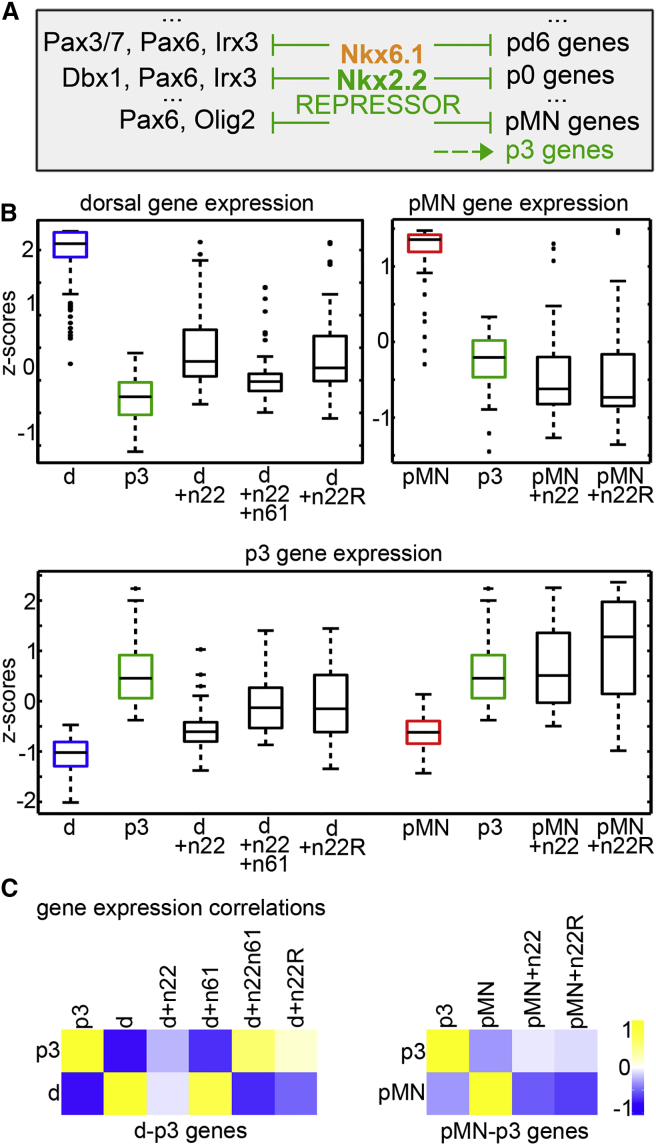
Regulation of Gene Expression Programs by NP-TFs Is Mediated by Repression(A–C) Nkx2.2 represses dorsal and pMN genes to induce p3. (A) Experimental rationale: to test whether repression of dorsal and pMN genes by Nkx2.2 is sufficient to allow the de-repression of p3-specific genes, a dominant inhibitory version of Nkx2.2 (n22R) was induced in iNPC-D or iNPC-pMN cells and the resulting transcriptome changes analyzed. (B) Nkx2.2HD-EnR is sufficient to repress a large fraction of dorsal and pMN genes and to induce p3 identity. Three groups of genes defined in Figure 1D were analyzed: “dorsal” genes (blue) that were expressed higher in iNPC-D than iNPC-p3 or iNPC-pMN, “pMN” genes (red) that were expressed higher in iNPC-pMN than iNPC-p3, and “p3” genes (green) expressed at higher levels in iNPC-p3 than iNPC-D or iNPC-pMN, expressed in p3 only or in p3 and FP progenitors. The boxplots correspond to the normalized expression levels of these genes in each of the conditions. A large fraction of dorsal and pMN genes was repressed in d + n22R and pMN + n22R cells. Conversely, a large fraction of p3 genes were induced in these progenitors, similar to the progenitors generated by ectopic induction of Nkx2.2 (d + n22, pMN + n22) or Nkx2.2 and Nkx6.1 (d + n22n61). (C) Consistent with B, Nkx2.2 and Nkx2.2HD-EnR induced a p3 gene signature when overexpressed in dorsal or pMN cells. Cross-correlation of dorsal and p3 genes (Pearson's correlation coefficient) between iNPC-D, iNPC-p3, and iNPC-D cells in which Nkx2.2, Nkx6.1, Nkx2.2/Nkx6.1, or Nkx2.2HD-EnR had been induced indicate that Nkx2.2HD-EnR induces a transcriptome signature similar to p3 cells. Similar cross-correlations of gene expression in pMN and p3 progenitors indicate that the induction of Nkx2.2 and Nkx2.2HD-EnR induce a p3 signature in iNPC-pMN.